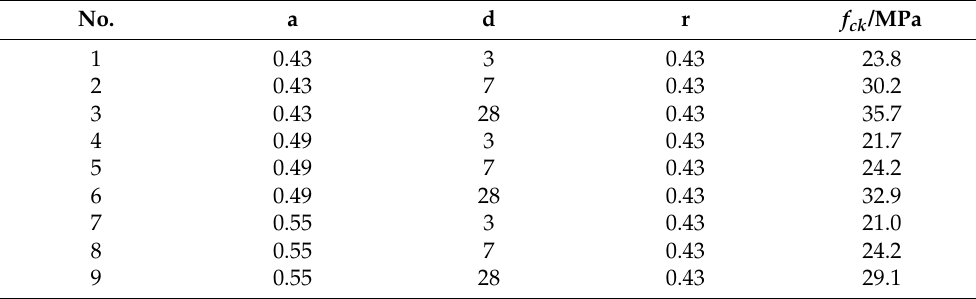
Table 2. Results of uniaxial compressive strength of concrete blocks.